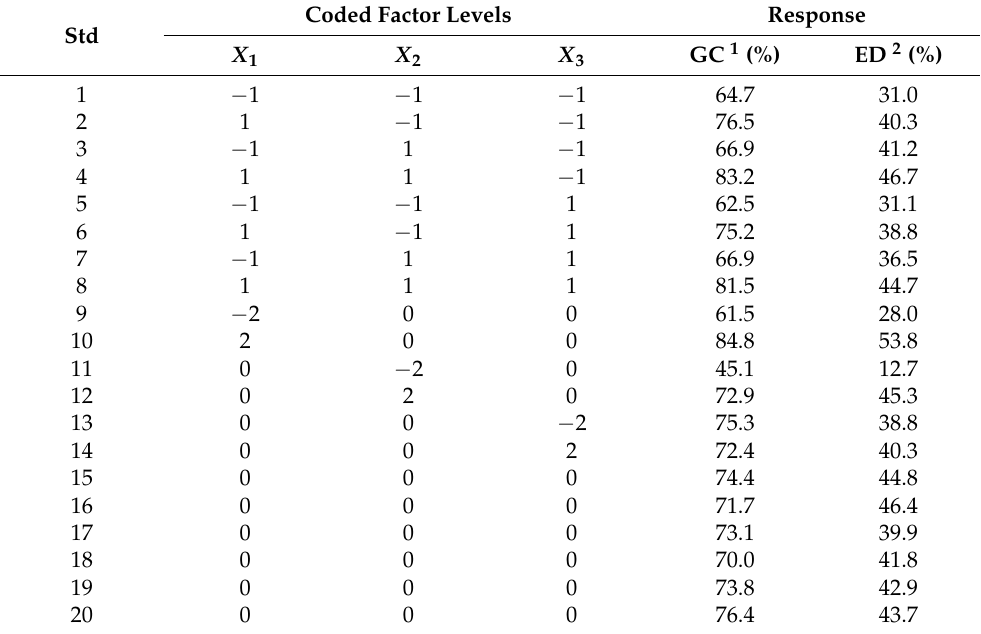
Table 3. Experimental designs and their experimental data for five-level, three-factor response surface analysis. Coded Factor Std